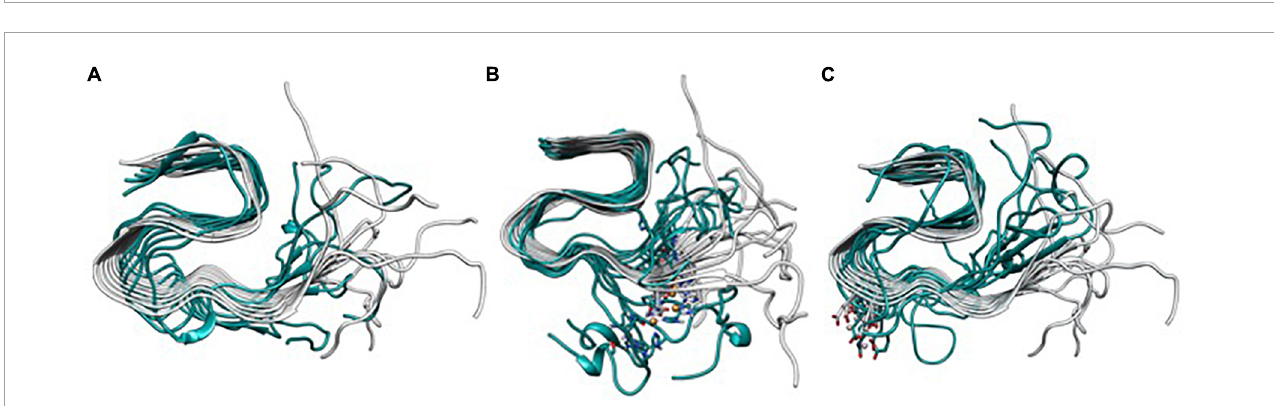
FIGURE8 Overlapping of the lowest energy structure obtained from the Gaussian accelerated molecular dynamics (GaMD) simulation of Metal-Free Fibril (A) , Cu(II) (B) , and Al(III) (C) against the A β 42